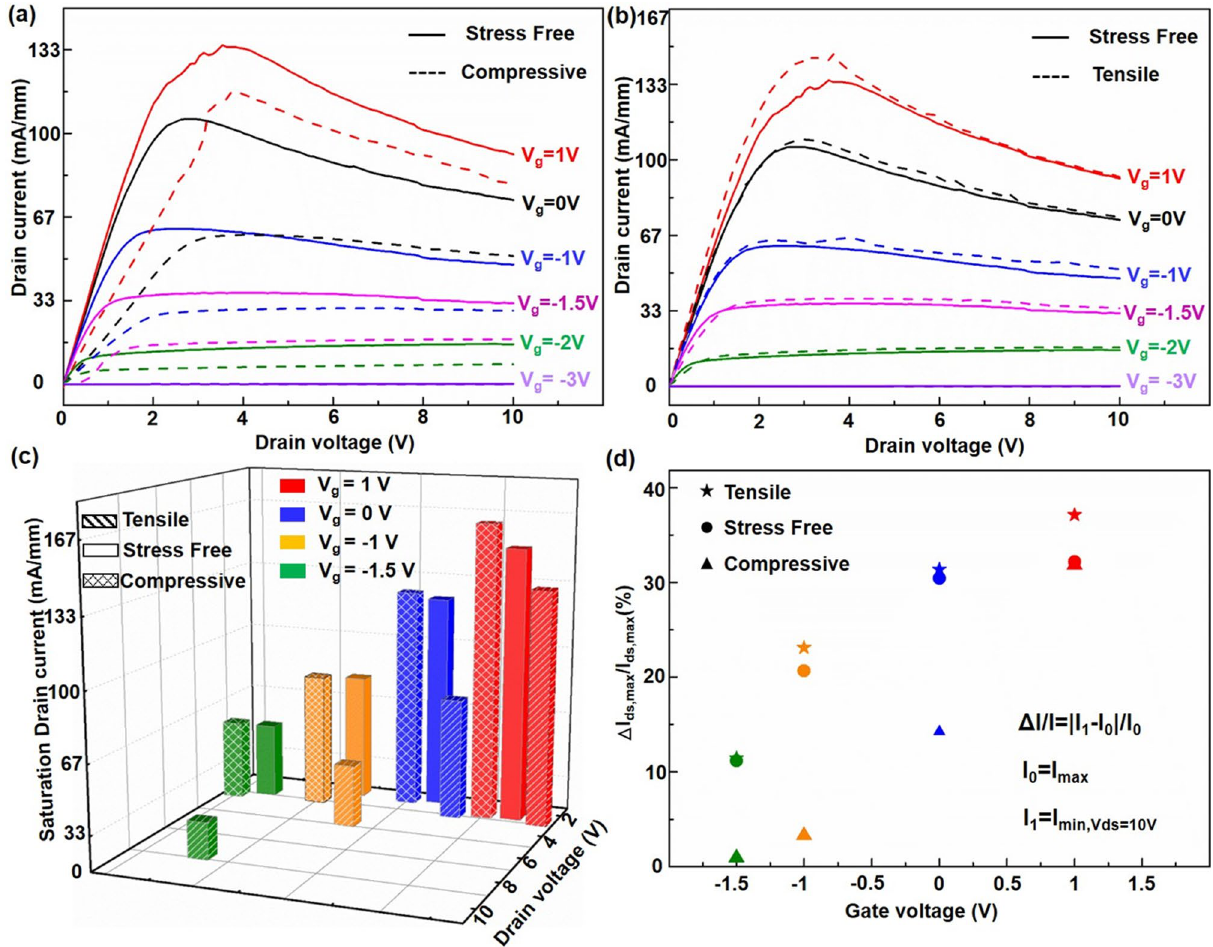
Fig. 5 Piezotronic effect and investigate on saturation drain current attenuation. a I–V characteristics of HEMTs under strain free, compressive and b tensile strain condition. c The saturation drain current value and the corresponding peak position changes. d The corresponding relative changes ( ΔI ds,max /I ds,max